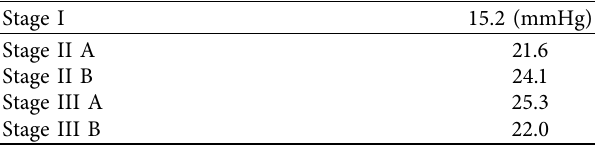
Table 2: PP variation according to the stage of